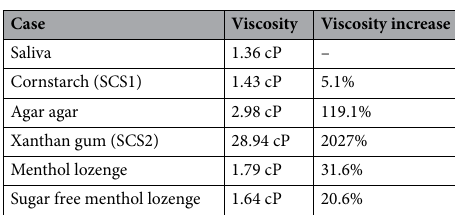
Table 1. High strain-rate viscosity